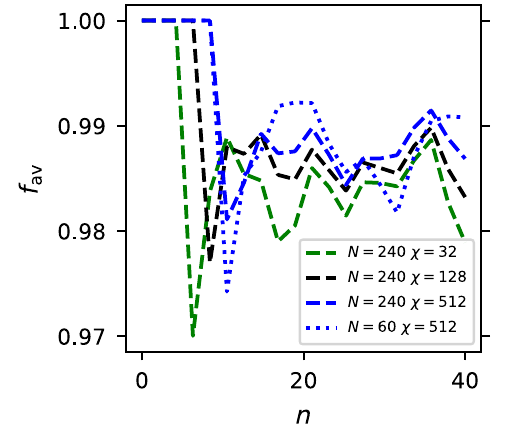
as a av FIG. 7. Fidelity F versus depth D for N ¼ 20 and various values of χ ¼ 10 , 20, 50. The symbols correspond to a direct calculation of F obtained by comparing with an exact calculation (i.e., without truncation). The lines correspond to the right-hand side of Eq.